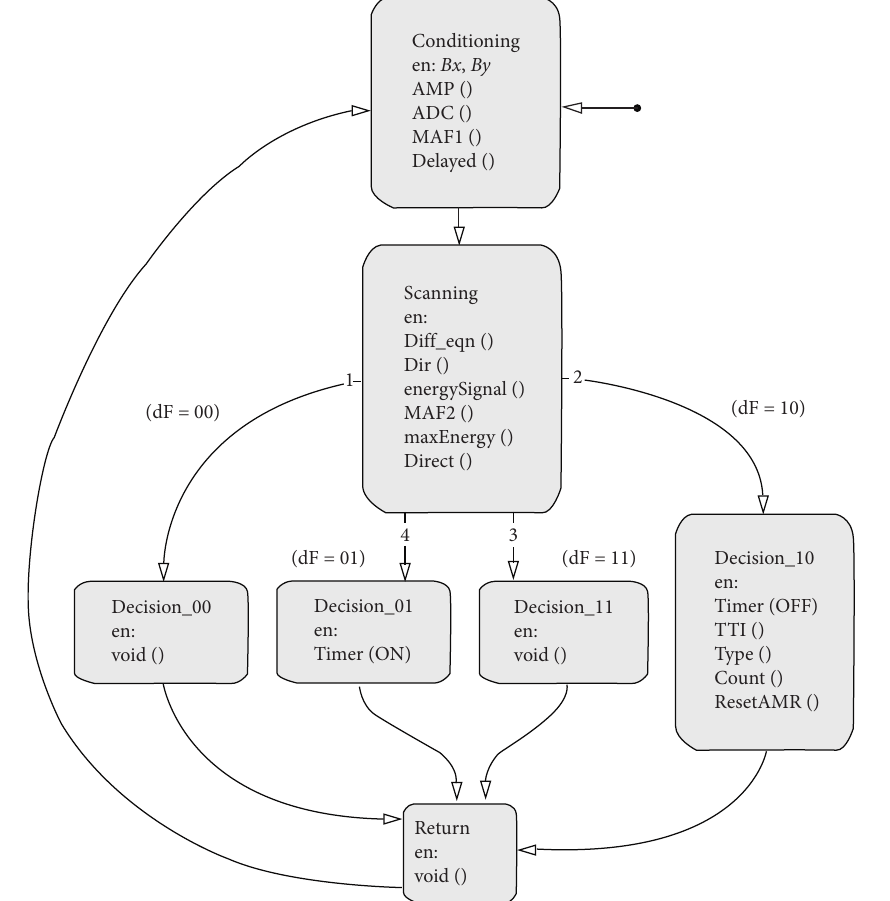
Figure 3: SDA-II Finite state-flow